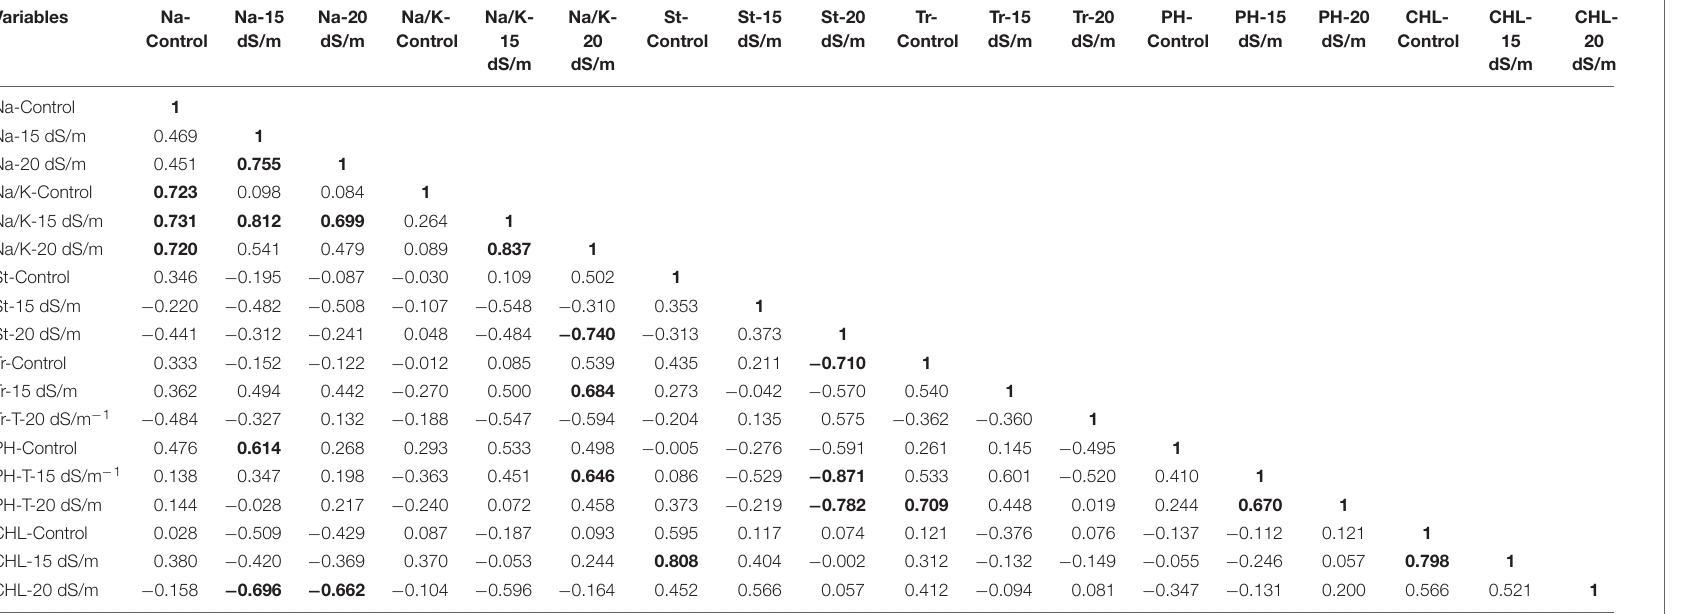
Values in bold are different from 0 with a significance level alpha = 0.05; Na + , Sodium concentration; Na + /K + , Sodium to Potassium ratio; St, Stomatal Conductance; Tr, Transpiration rate; PH, Photosynthetic rate; CHL, Chlorophyll